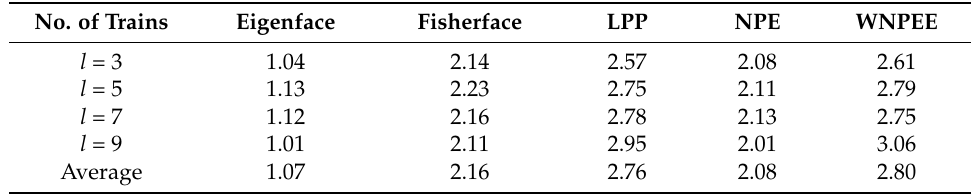
( d ) Figure 6. Average recognition rate versus reduce dimensions on CMU PIE dataset. ( a ) l = 10, ( b ) l = 15, ( c ) l = 20, and ( d ) l = 25. To evaluate the computation complexity we record the time consumed for all DR techniques for one run which are shown in Table 4. The time is in seconds with different values of trains. Time results reveals that proposed method is almost equal in terms of computations. However, a slight difference in time makes our proposed WNPEE slow, but its performance makes it a competitive algorithm in the field of DR.